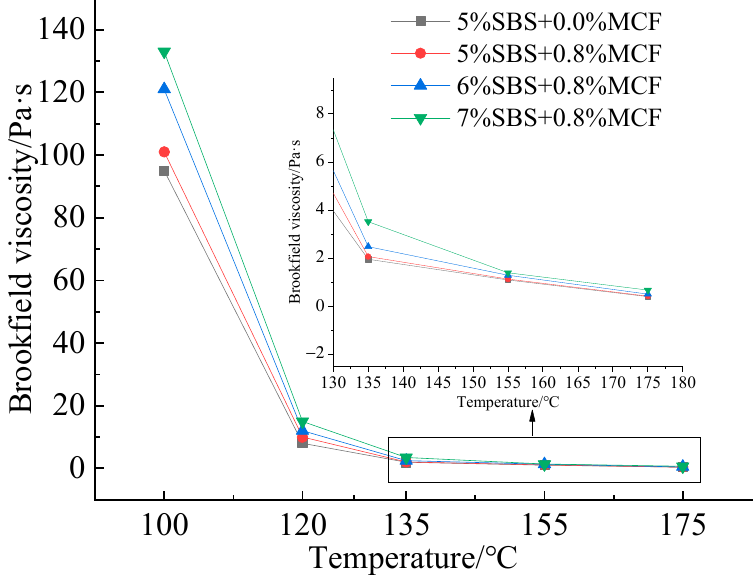
Figure 3. Rotational viscosity test result for the modified asphalt.